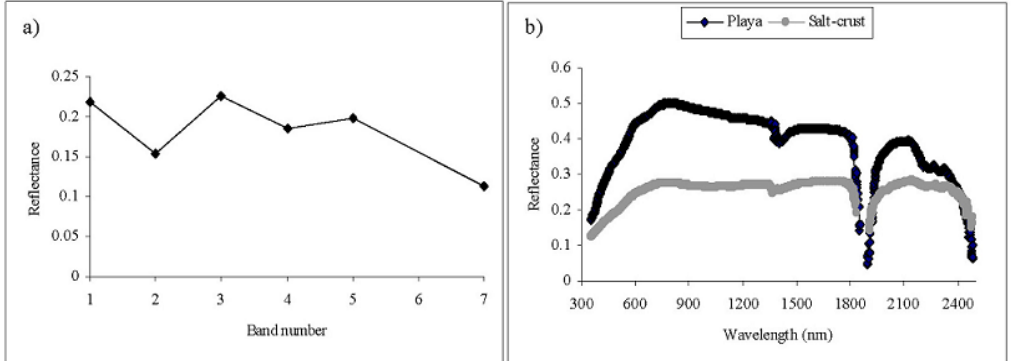
Figure 2 . Spectral reflectance of salt-affected soils collected by using (a) Landsat TM image and (b) Spectroradiometer. Spectral properties of salt-affected soils in the study area were measured in the field almost at the same acquisition time of Landsat TM images (August 17, 2005). The spectral reflectance was measured using the FieldspecfiPro, manufactured by Analytical Spectral Devices of Boulder Colorado. The instrument has a field of view of 25 mm. It covers the spectral range from 350 to 2,500 nm with an average bandwidth of 1